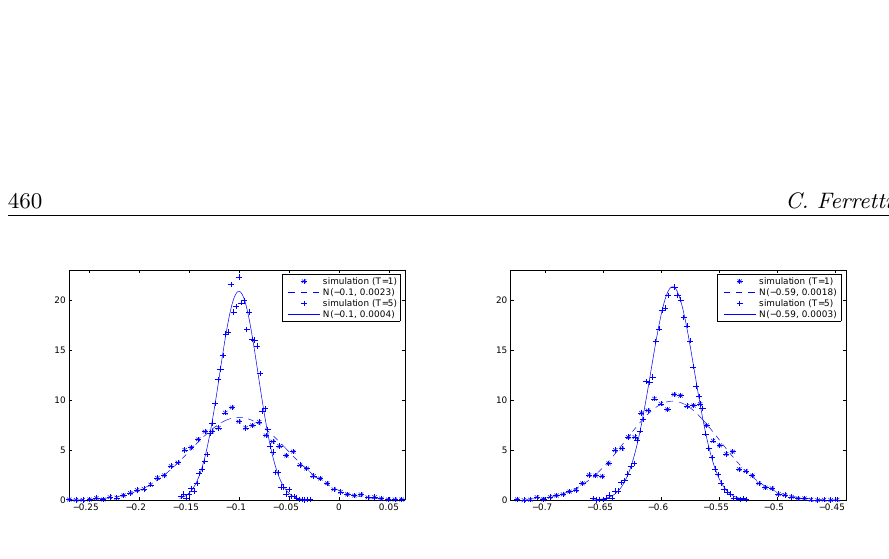
Figure 1 – Simulated versus theoretical density distribution of I (cid:3) ( ˆ P ), with !